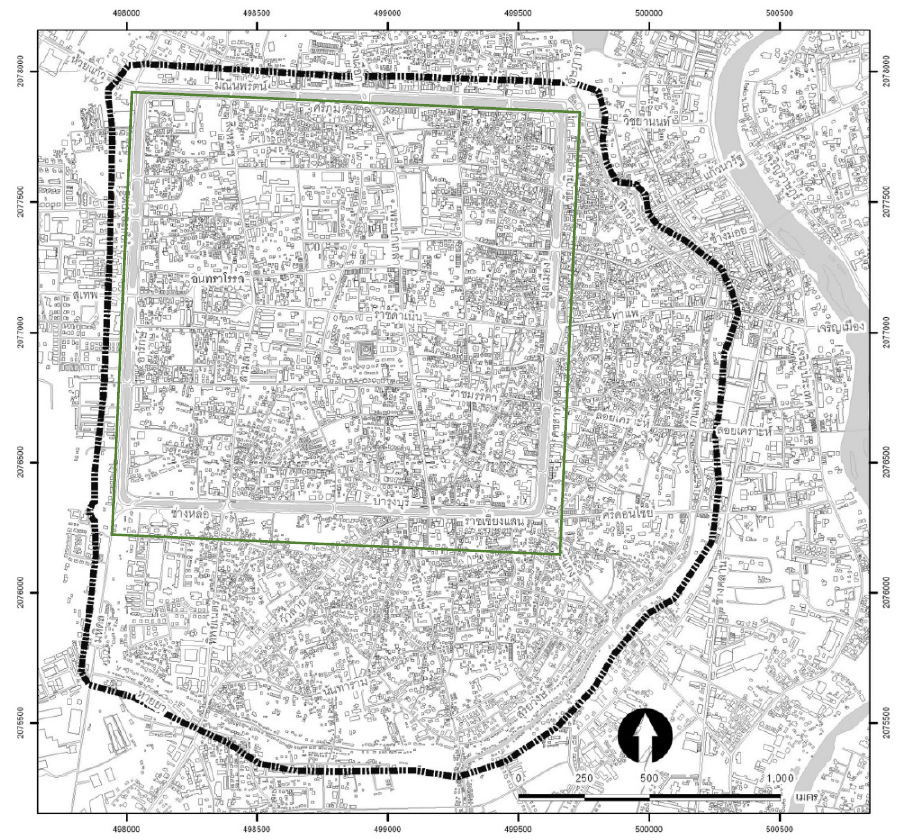
Figure 4. The study area is highlighted in green line, the map of Chiang Mai Old City, Thailand and the boundary of Old City following the Chiang Mai municipal law (Cultural and Natural Environment Management Bureau 2016).